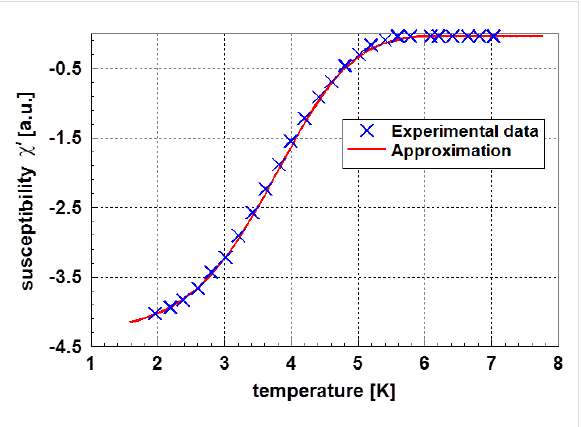
Figure 6: Real part of the magnetic susceptibility χ ’ of lead as function of the temperature in the vicinity of the transition to the supercon- ducting state according to Li et al. [8]. Additionally, the approximation according to Equation 7 is